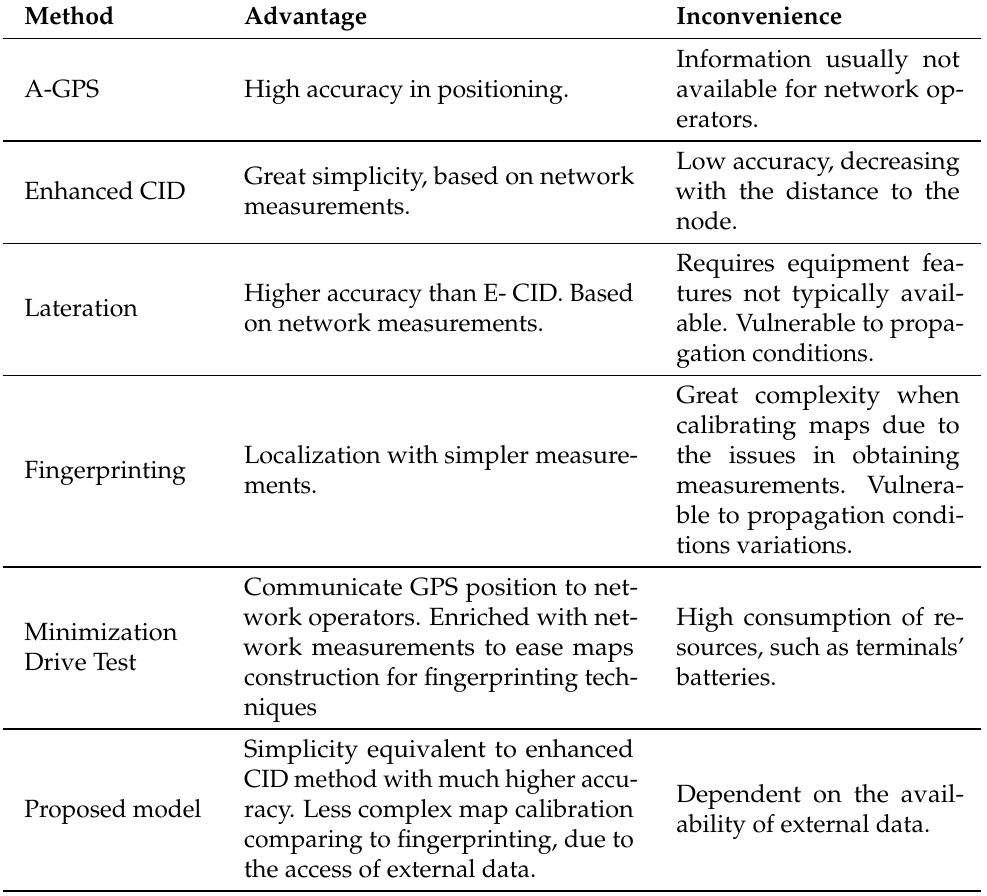
Table 1. Positioning